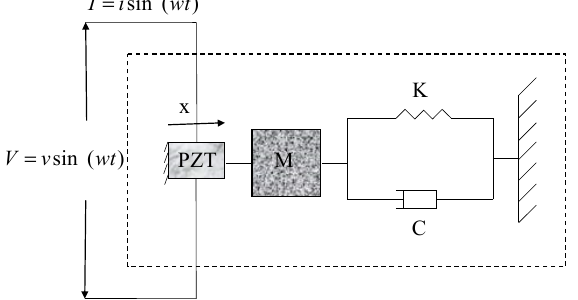
Figure 1. The electromechanical impedance model of a Lead Zirconate Titanate (PZT)-driven structural system.